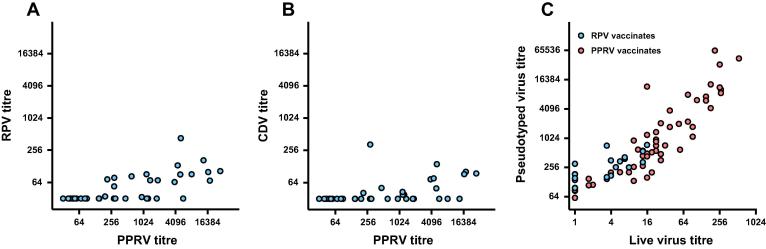
Comparison of neutralising antibody titres against VSV(PPRV) with those against VSV(RPV), VSV(CDV) or PPRV live virus. Goat sera were screened simultaneously for neutralising activity against VSV pseudotypes bearing PPRV (Nigeria/75/1) and either (A) RPV (Kabete O) or (B) CDV (Onderstepoort) glycoproteins. (C) In a separate experiment, sera from cattle vaccinated with live attenuated RPV (blue circles) or PPRV (red circles) vaccines and with known antibody titres against live PPRV Nigeria/75/1virus, were re-screened for neutralising activity against VSV(PPRV Nigeria/75/1). Antibody titres in the pseudotyped virus assay (A, B, C) were calculated based on a 90% reduction of infectivity relative to the no serum control (three replicates per dilution). Antibody titres in the live virus based assay (C) were expressed as the reciprocal of the antibody dilution at which 50% of the wells showed virus growth (six replicates per dilution). (For interpretation of the references to color in this figure legend, the reader is referred to the web version of this article.)